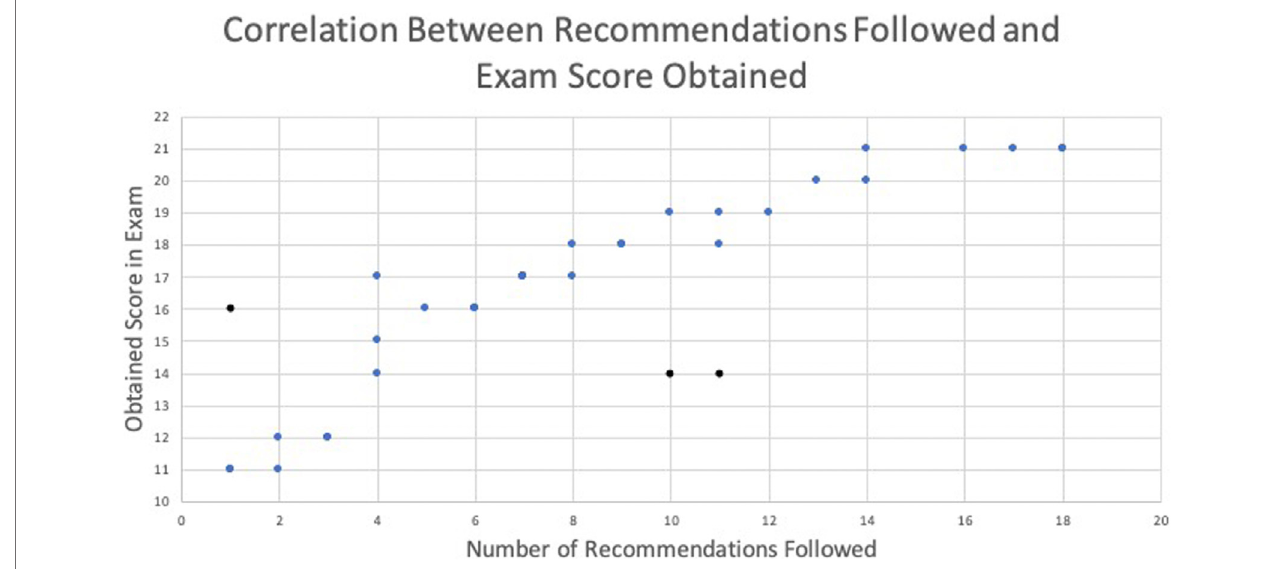
FIGURE 9 | Correlation between recommendations followed and students ’